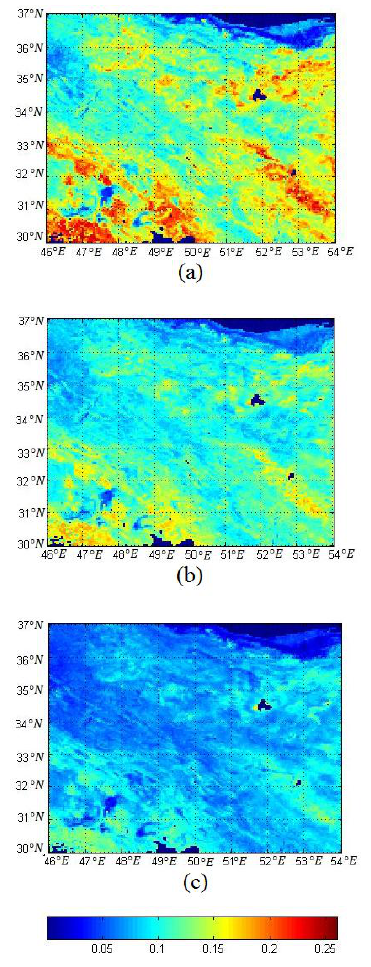
Figure 2. MRT surface reflectance spring 2005. (a) At band 1 (0.66 μm), (b) band 4 (0.55 μm), (c) band 3 (0.47